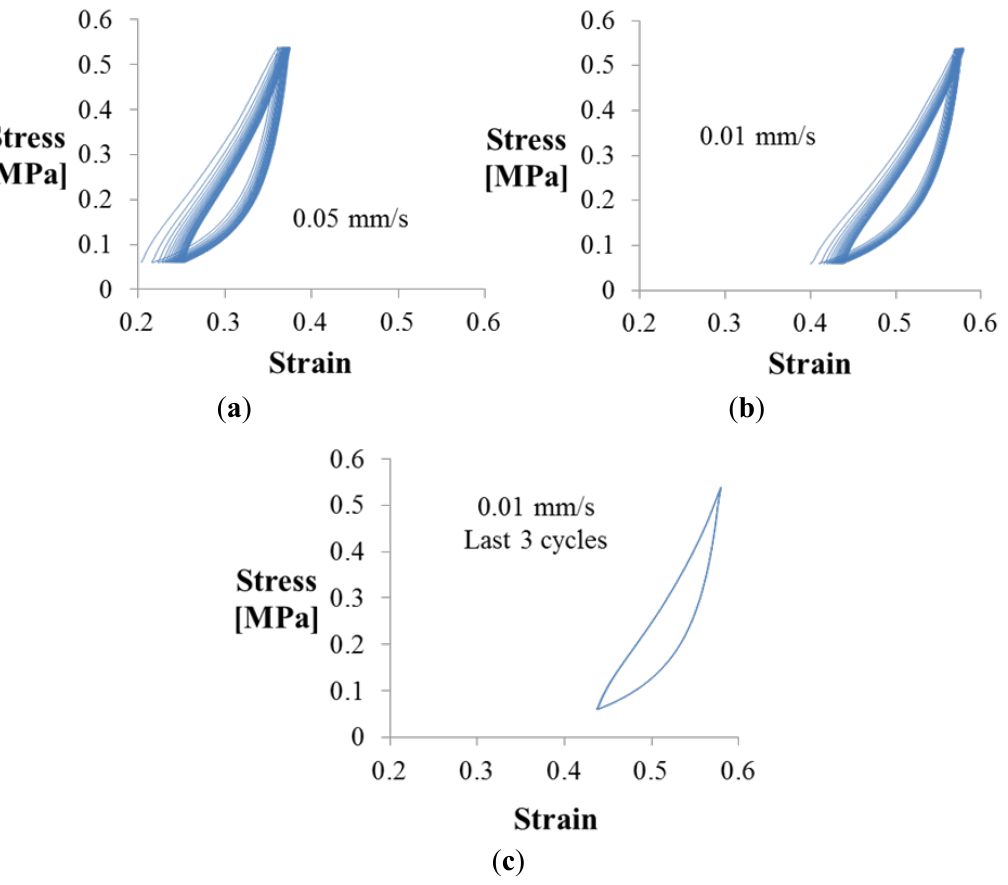
Figure 2. Stress vs. strain curves for the constrained sample. Cycles performed between 10 and 90 N loads using Plexiglas fixture to maintain constant area. The first loading cycle from 0 to 90 N has been removed. ( a ) Cycling behavior at a rate of 0.05 mm/s; ( b ) Cycling at frequencies of 0.01 mm/s; and ( c ) Values reach a reproducible and stable profile after the first conditioning 15–17